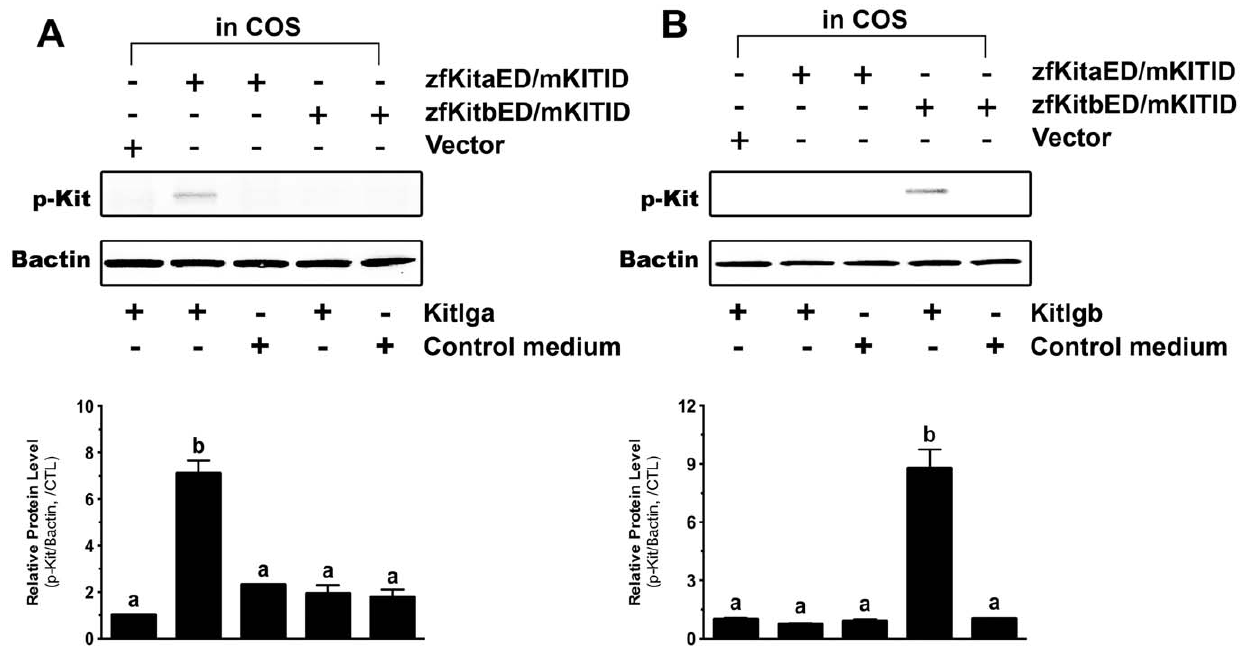
Figure 7. Response of the chimeric zebrafish/mouse Kit receptors to zebrafish Kitlga and Kitlgb. The COS-1 cells expressing zfKitaED/ mKITID and zfKitbED/mKITID were treated with recombinant Kitlga (A) and Kitlgb (B) for 10 min followed by Western blot analysis for Kit phosphorylation. The control medium was from the CHO cells carrying the control plasmid pcDNA5/FRT. The expression plasmid pCMV-Script (Vector) was used as the control in the COS-1 cells. The densitometric analysis of the Western signals is shown at the bottom of each graph. The data were normalized to Bactin and expressed as the fold change compared to the first group (mean 6 SEM, n=3). Different letters indicate statistical significance ( P , 0.05). p-Kit, Kit phosphorylation; + , recombinant ligand proteins were added or cells were transfected with specific receptor plasmids; 2 , no recombinant ligands or transfection with receptor plasmids.